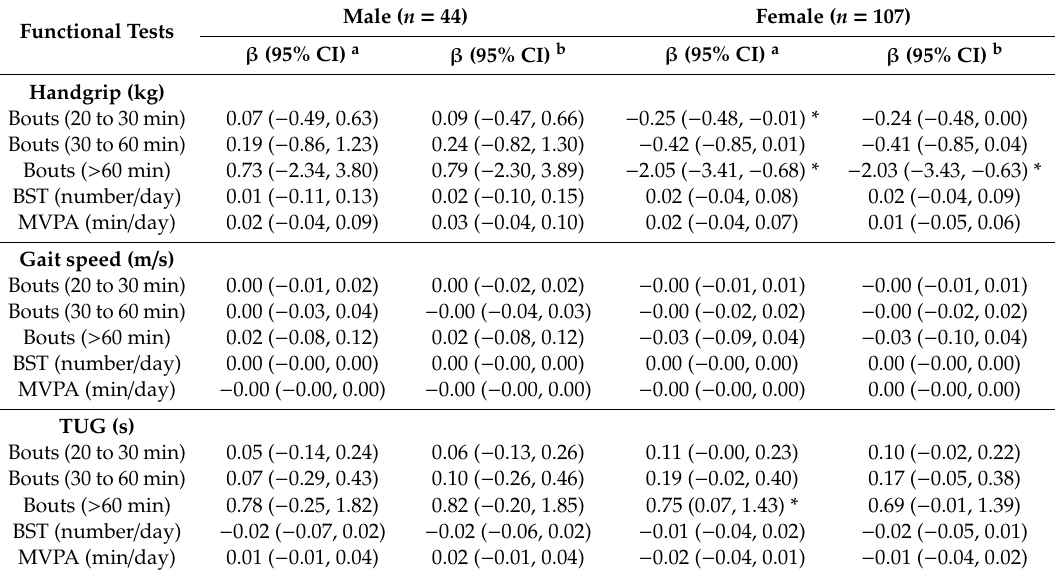
Table 3. Cross-sectional associations of MVPA and sedentary patterns with physical function controlling for sex.